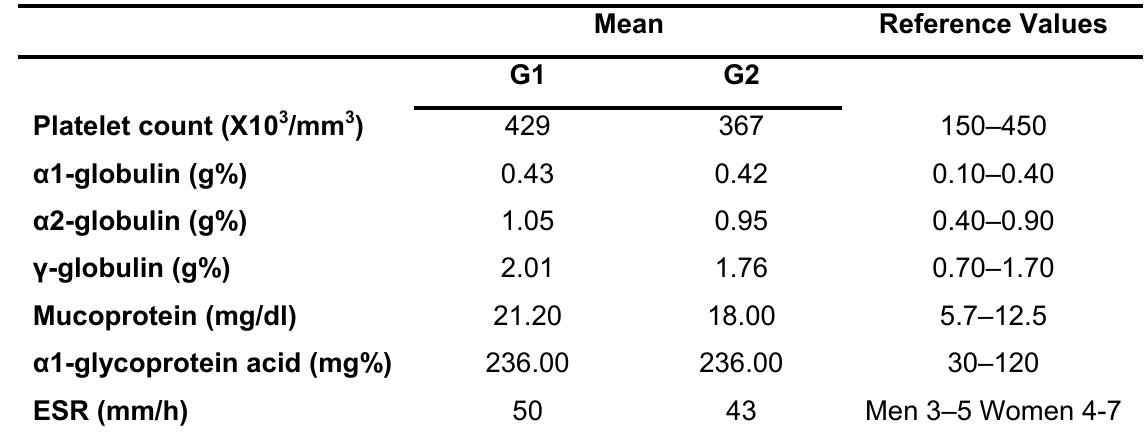
Table 3. Analysis of hematological and biochemical parameters of patients with pulmonary